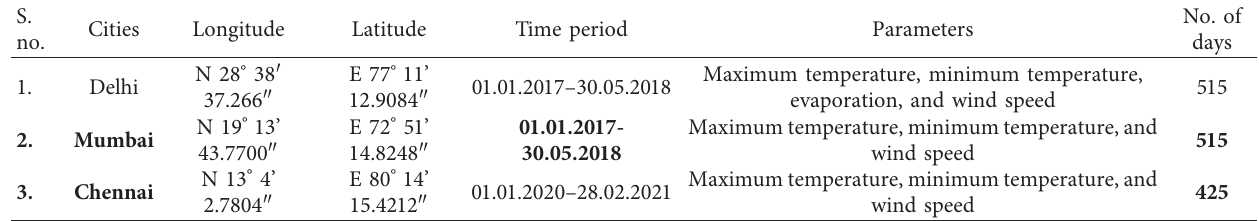
Table 1: Details of the data